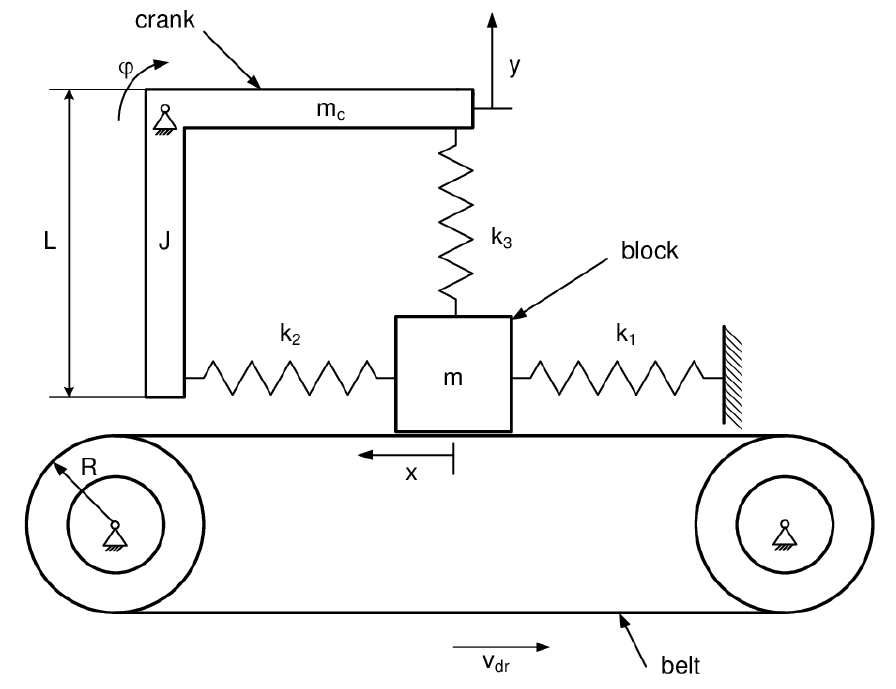
Figure 3 The scheme of the mechanism represented in Fig.